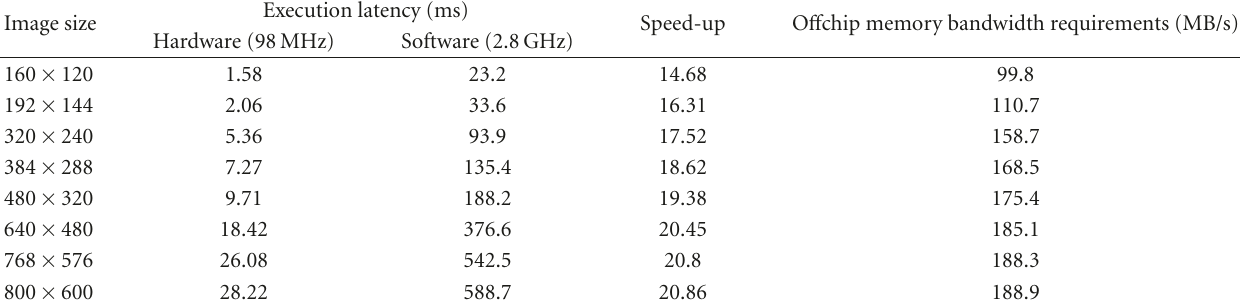
Table 5: Performance comparison between the hardware and software solution and the o ff chip memory bandwidth